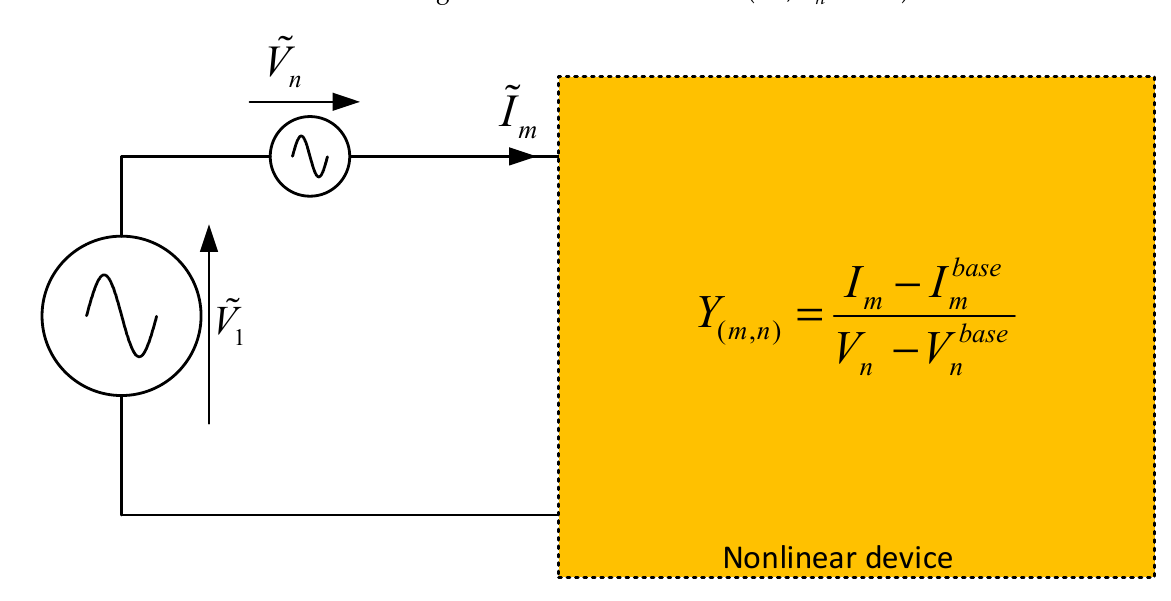
Figure 2. Perturbations to determine the admittance loci.